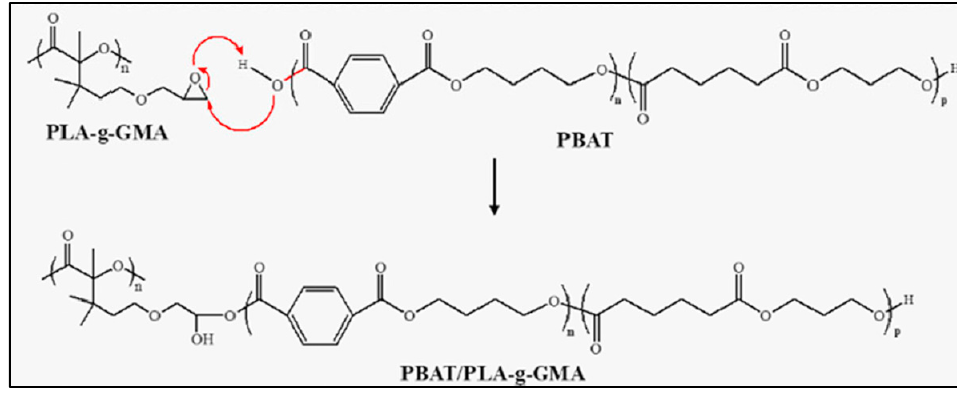
Figure 15. Mechanism of the reaction between PLA- g -GPA and PBAT (from Lyu et al. [78], copyright Elsevier, reproduced with permission).